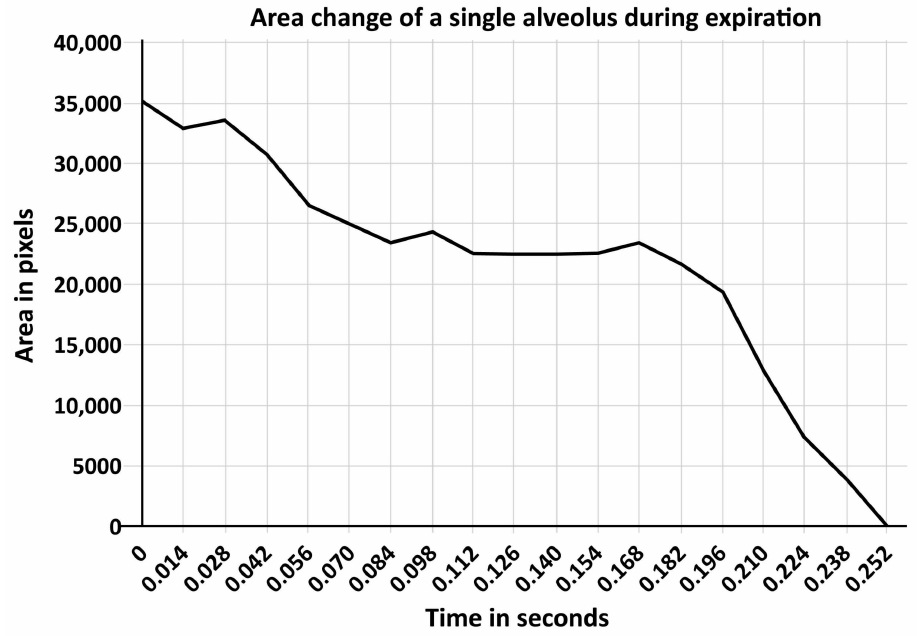
Figure 3. Graphic presentation of the time course of alveolar collapse during the expiration by releasing an airway pressure of 25 cm H 2 O to zero as depicted by in-vivo microscopy in rats with surfactant-deactivated lung. The Y-axis represents the alveolar surface areas in pixels and the X-axis is the time. There is a time lag of 0.17 s before alveoli start to collapse after the initiation of the expiratory phase. Furthermore, it takes 0.25 s before the alveoli are fully collapsed. Figure from Satalin, et al. (2016) [103], presented at ‘The Open Forum Sessions’ during the AARC Congress